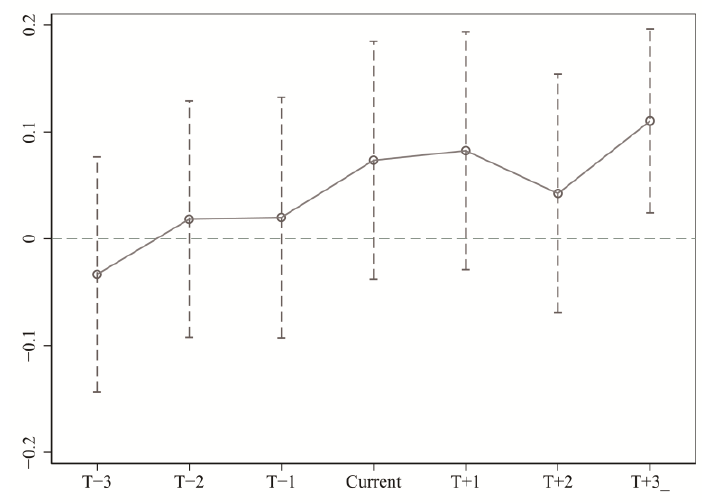
Figure 2. Parallel trend test.